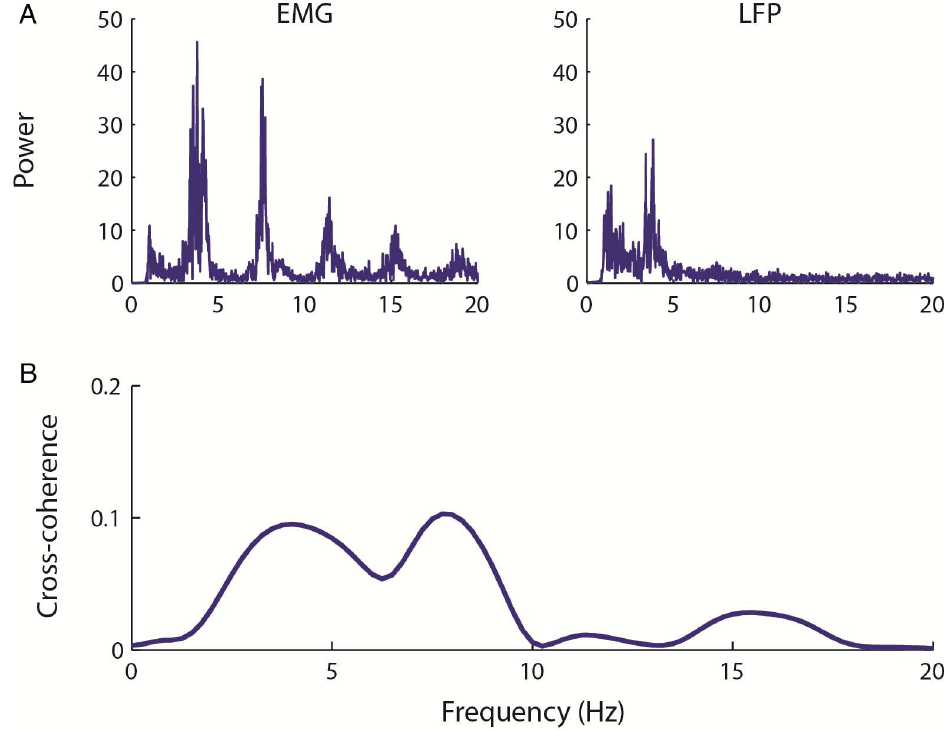
Fig 2. A representative simultaneous recording of EMG and LFP from one ET patient. In (A), the power spectra are shown for the EMG and the LFP across the entire recording.The EMG spectrum clearly shows a tremor band peak at 4Hz and subsequent peaks at the harmonic frequencies. The LFP also shows a 4Hz peak, althoughwith smaller power. (B) The Cross-coherence betweenthe EMG and LFP revealsa peak at 4Hz and the harmonic